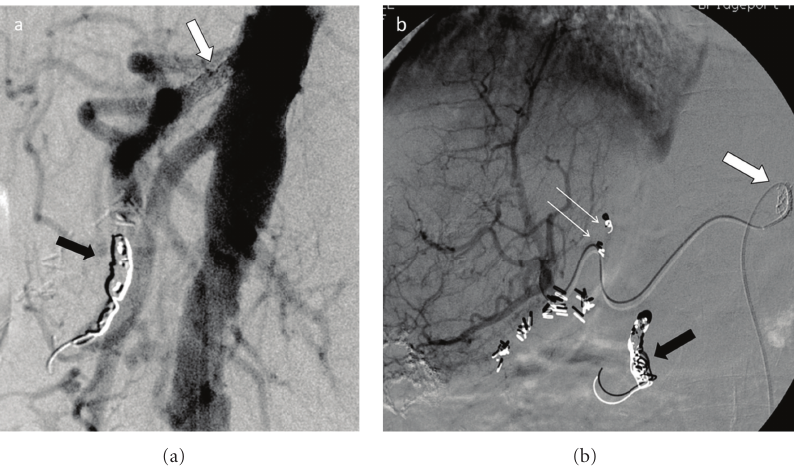
Figure 3: Treatment phase right hepatic angiogram images (a, b) demonstrate celiac artery stenting (6 × 15mm Cordis chromium balloon expandable stent, white arrows) resulting in widely patent celiac axis with accessibility to the hepatic arteries. Coil embolization of gastroduodenal artery (two 10mm × 10cm tornado coils and two 8 mm × 4cm coils, black arrows) prevents abnormal extrahepatic distribution. Additionally, a small accessory right hepatic branch was also coil embolized (two 3 × 2mm platinum coils, white line arrows on (b)) to allow safer dose delivery and probable intrahepatic vascular flow redistribution [1, 2]. 90 Y microspheres were injected within the right hepatic artery till end point without any immediate complications.